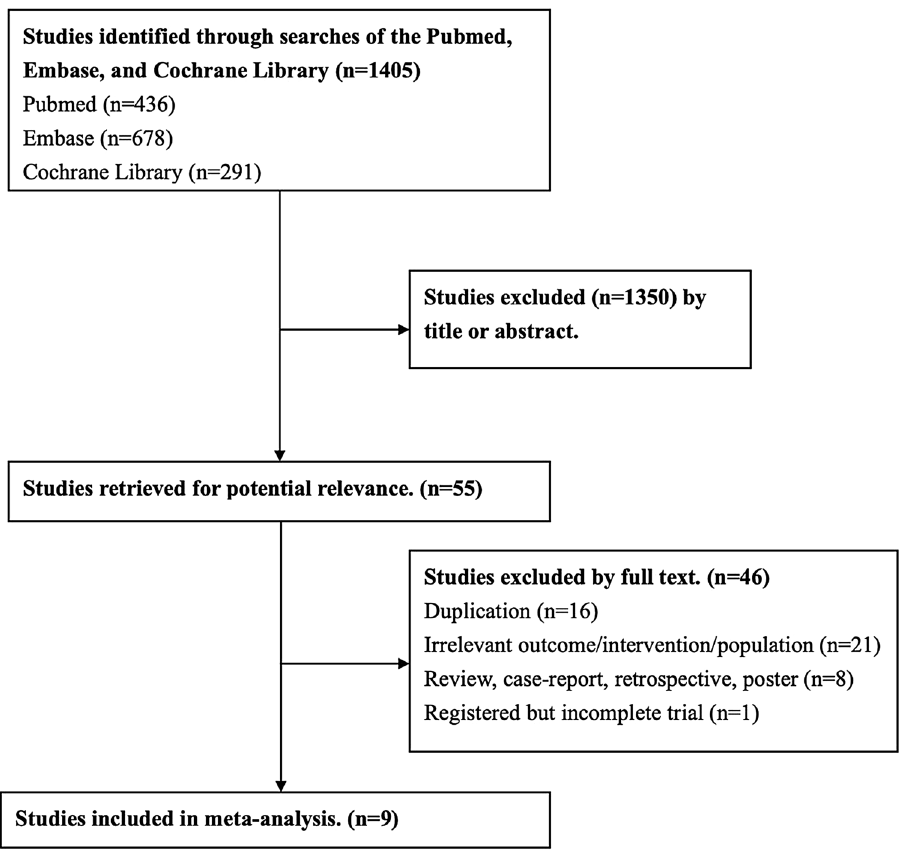
Figure 1. Flowchart of trial